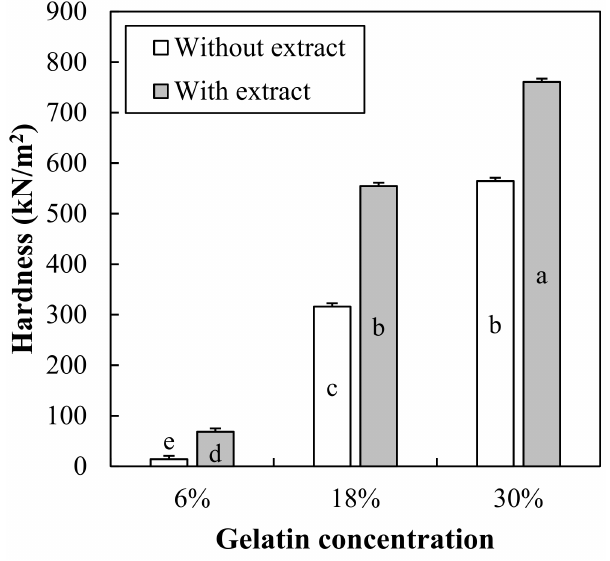
Figure 6. Hardness of 6%, 18%, and 30% gelatin gels formulated with red maple leaf extracts (1000 mg/L). Error bars represent standard error of the means. a–e Means with the same letter are not significantly different ( p ≥